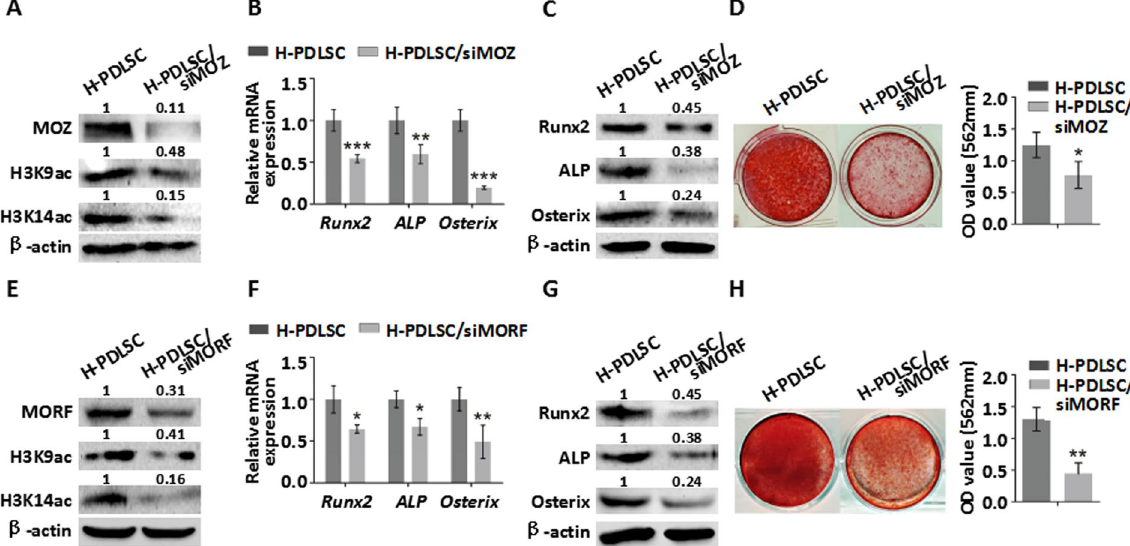
Figure 3. Osteogenic differentiation of H-PDLSCs with MOZ & MORF depletion. ( A ) Protein expression of MOZ, H3K9ac and H3K14ac in H-PDLSCs and H-PDLSCs with siMOZ. ( B ) Gene expression of Runx2, ALP and Osterix in H-PDLSCs and H-PDLSCs with siMOZ after osteogenic induction. ( C ) Protein expression of Runx2, ALP and Osterix in H-PDLSCs and H-PDLSCs with siMOZ after osteogenic induction. ( D ) ARS staining of H-PDLSCs and H-PDLSCs with siMOZ and quantification of it for light absorbance at 562 nm. ( E ) Protein expression of MORF, H3K9ac and H3K14ac in H-PDLSCs and H-PDLSCs with siMORF measured by western blot. ( F ) Gene expression of Runx2, ALP and Osterix in H-PDLSCs and H-PDLSCs with siMORF after osteogenic induction. ( G ) Protein expression of Runx2, ALP and Osterix in H-PDLSCs and H-PDLSCs with siMORF after osteogenic induction. ( H ) ARS staining of H-PDLSCs and H-PDLSCs with siMORF and quantification of it for light absorbance at 562 nm. * P < 0.05, ** P < 0.01, *** P < 0.001, n =